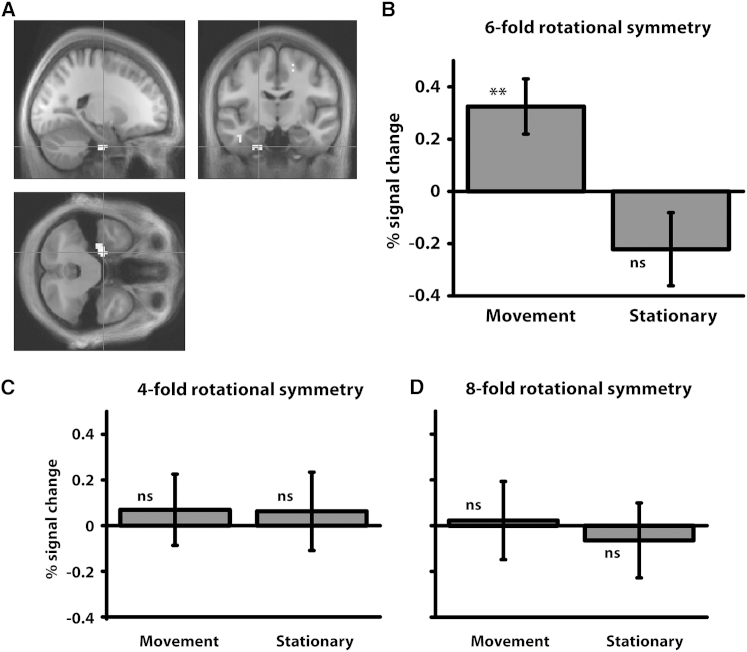
Movement-Related Grid-like Signal(A) Sinusoidal modulation of BOLD response by heading angle with 6-fold rotational symmetry for movement > stationary periods in EC (−21, −12, −36; p < .05 SVC; shown at p < .005 unmasked for display purposes; see Figure S3B for a masked image), from the split-half analysis where grid orientation was estimated on half the data and applied to the other half, separately for movement, stationary, and imagination periods.(B) % signal change from peak shown in (A) for 6-fold rotational symmetry during movement and stationary periods.(C and D) % signal change for peak shown in (A) for 4- and 8-fold rotational symmetries during movement and stationary periods. Note that we saw no effect for 4- or 8-fold symmetries in the entire EC, i.e., the null effect shown here is not specific to the region of interest based on the 6-fold analysis. Error bars show ±1 SE; ∗∗p < .01; ns, not significant (relative to baseline).